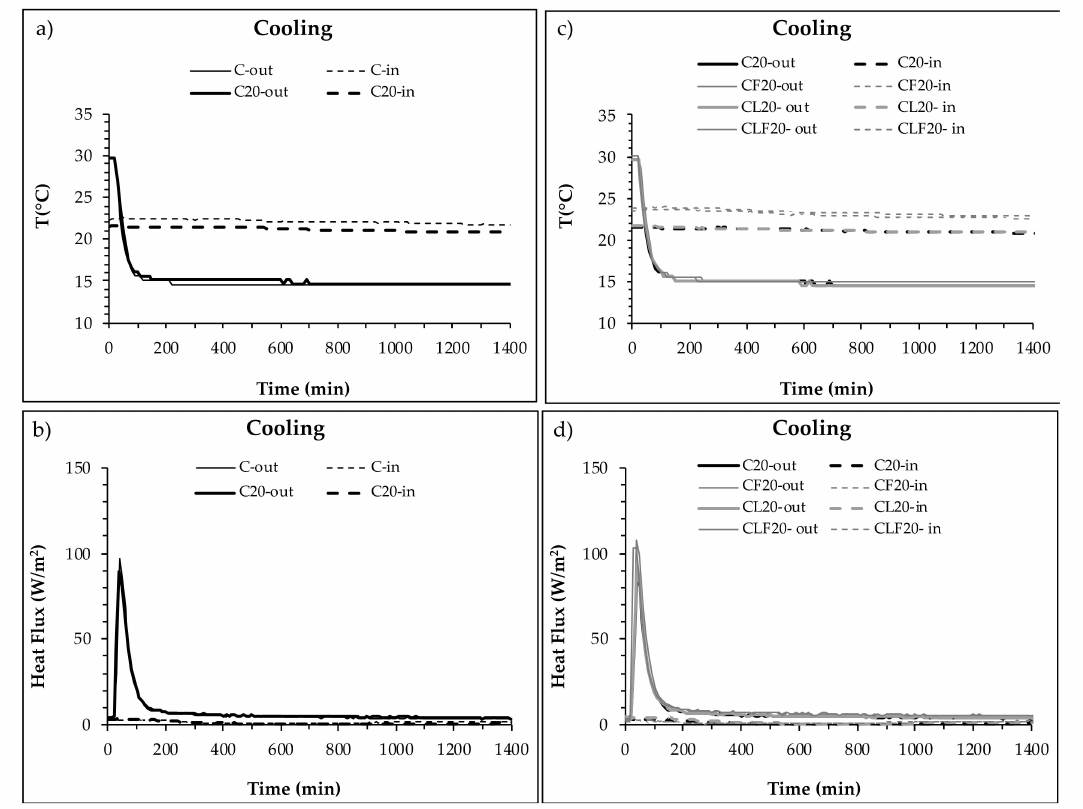
Figure 6. Temperature and heat flux monitored on the inner and outer sides of enclosures with a PCM cement-lime mortar layer during a cooling cycle (from 30 ◦ C to 15 ◦ C). ( a ) Temperature of enclosures with and without PCM mortar layers (C and C 20 ). ( b ) Heat flux of enclosures with and without PCM mortar layers(CandC 20 ). ( c )Temperatureofenclosureswithdi ff erenttypesofPCMmortar(C 20 , CF 20 , CL 20 and